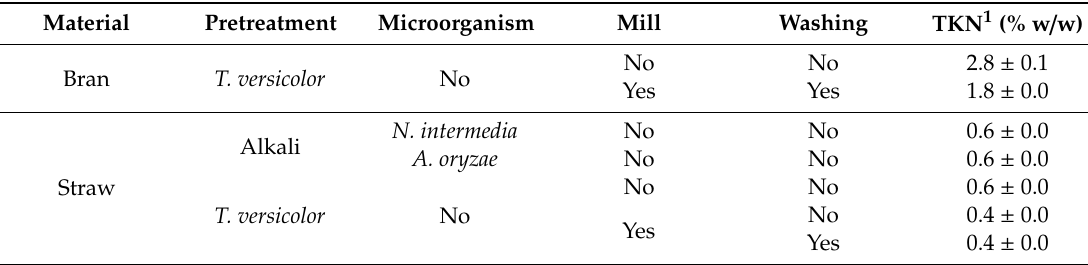
Table 3. Nitrogen content of selected samples.